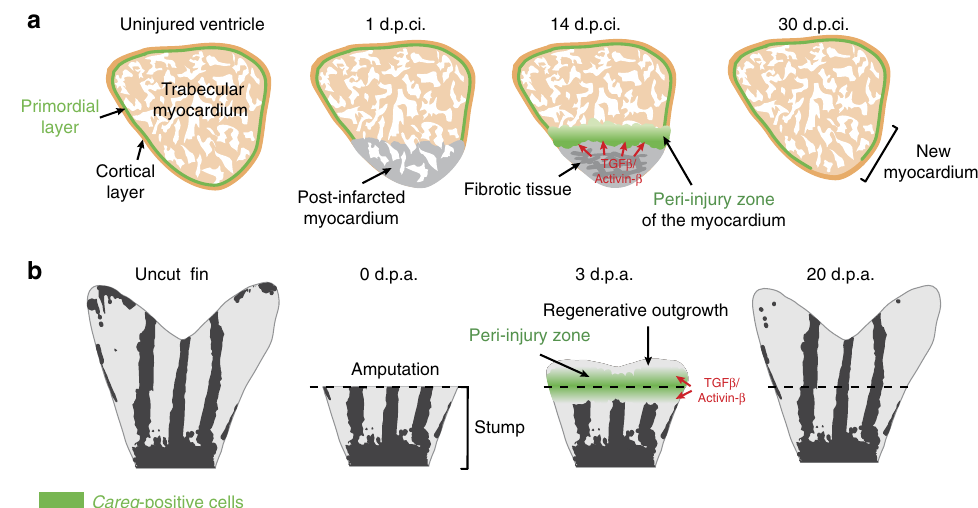
Figure 10 | CMs and stump MES activate a common regulatory element during regeneration. ( a , b ) A schematic representation of ventricle sections and whole fins at different time points during regeneration. The peri-injury zone of the ventricle and the stump of the fin activate a transient expression of the careg reporter in a TGF b /Activin- b -dependent manner. In the heart, the careg reporter also demarcates the primordial layer, which fails to be completely restored in the new